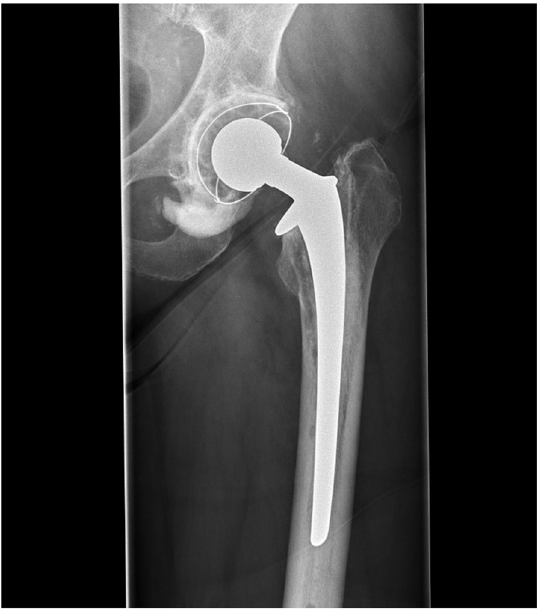
Fig. 3 Illustration of an iliopsoas tenotomy. Illustration of iliopsoas impingement because of a large protruding acetabular cup. Tenotomy of the irritated psoas tendon is performed at the level of the